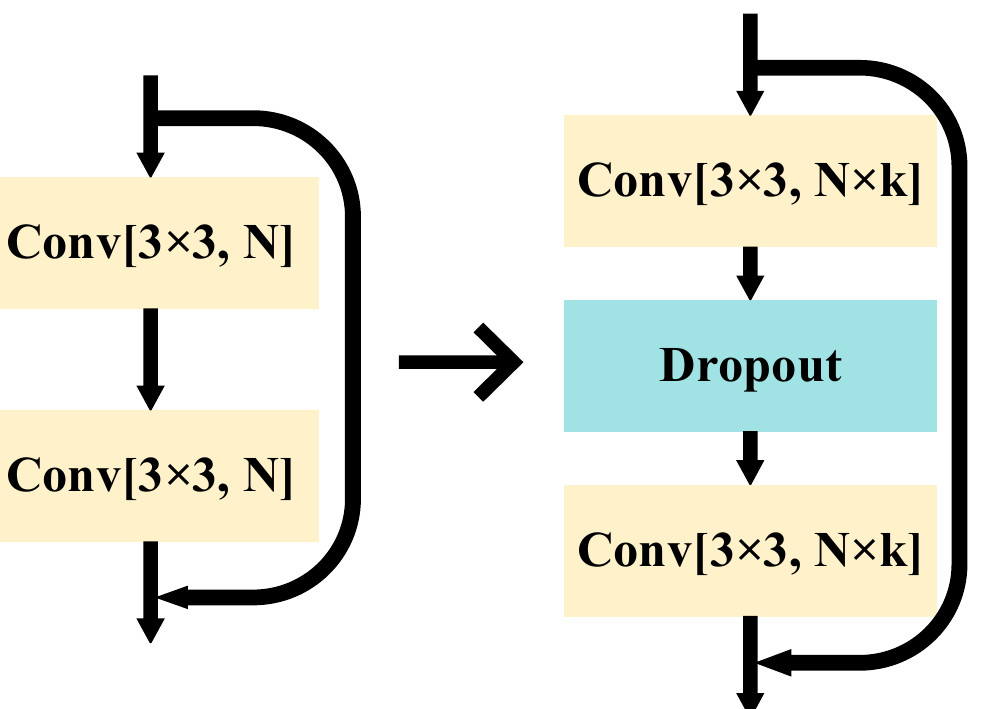
Figure 2. Schematic diagram of the relationship between ResNet block ( left ) and wide-ResNet block ( right ).